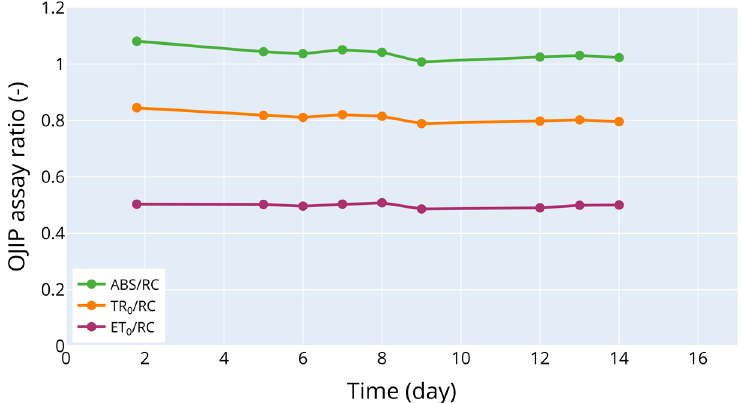
Figure 3. PhotoSystem II key parameter from OJIP assay. ABS/RC—light absorption per reaction center. TR 0 /RC—trapping per reaction center. ET 0 /RC—transfer per reaction center. Tests conducted on fresh samples after 15 min of dark adaptation.